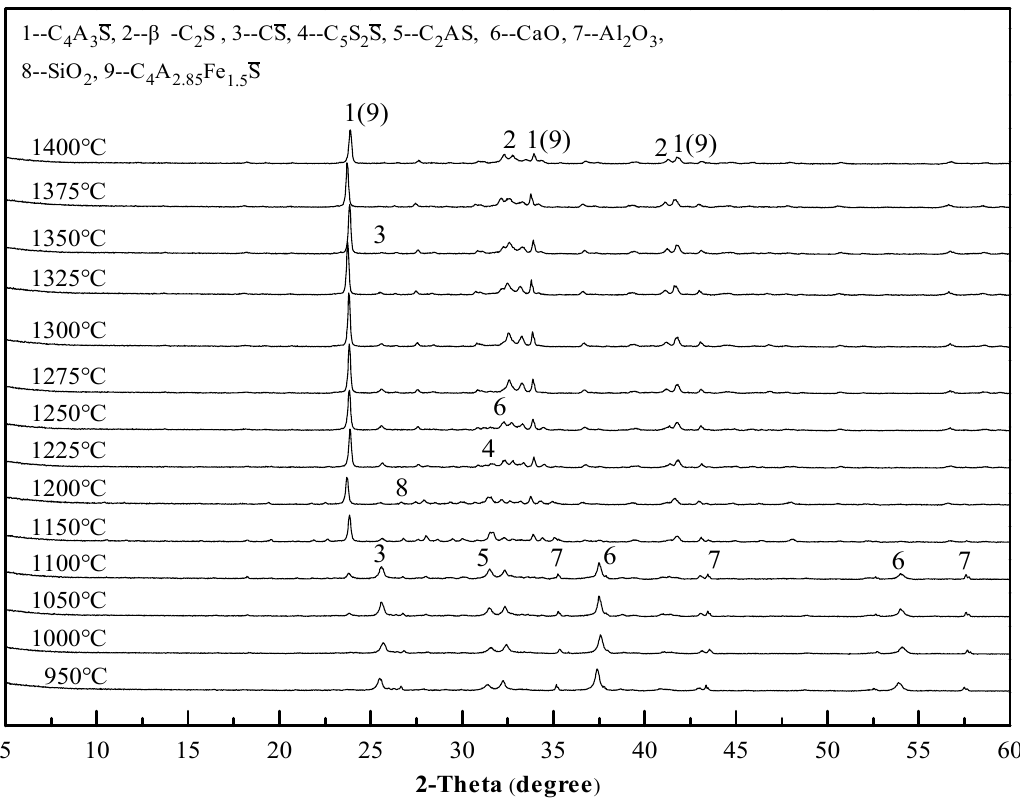
Figure 4. X-ray diffraction (XRD) patterns of the sample II-1 cement clinker at different temperatures. Figure 4. X-ray di ff raction (XRD) patterns of the sample II-1 cement clinker at di ff erent